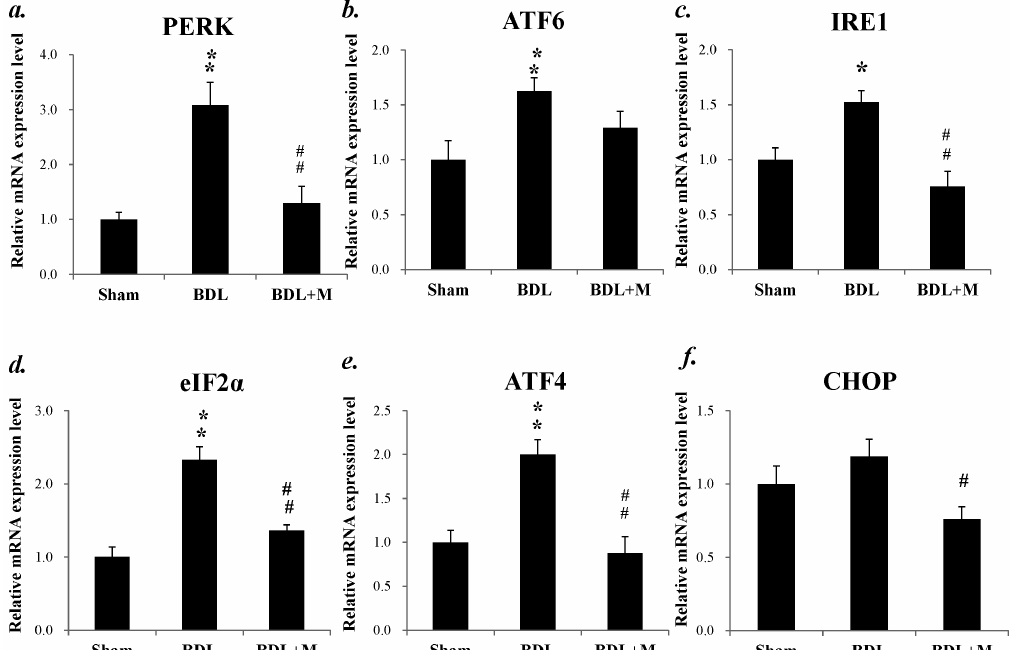
Figure 10. ( a ) Increased mRNA expression of protein kinase RNA-like endoplasmic reticulum kinase (PERK) in BDL rats and responded well to melatonin treatment; ( b ) increased